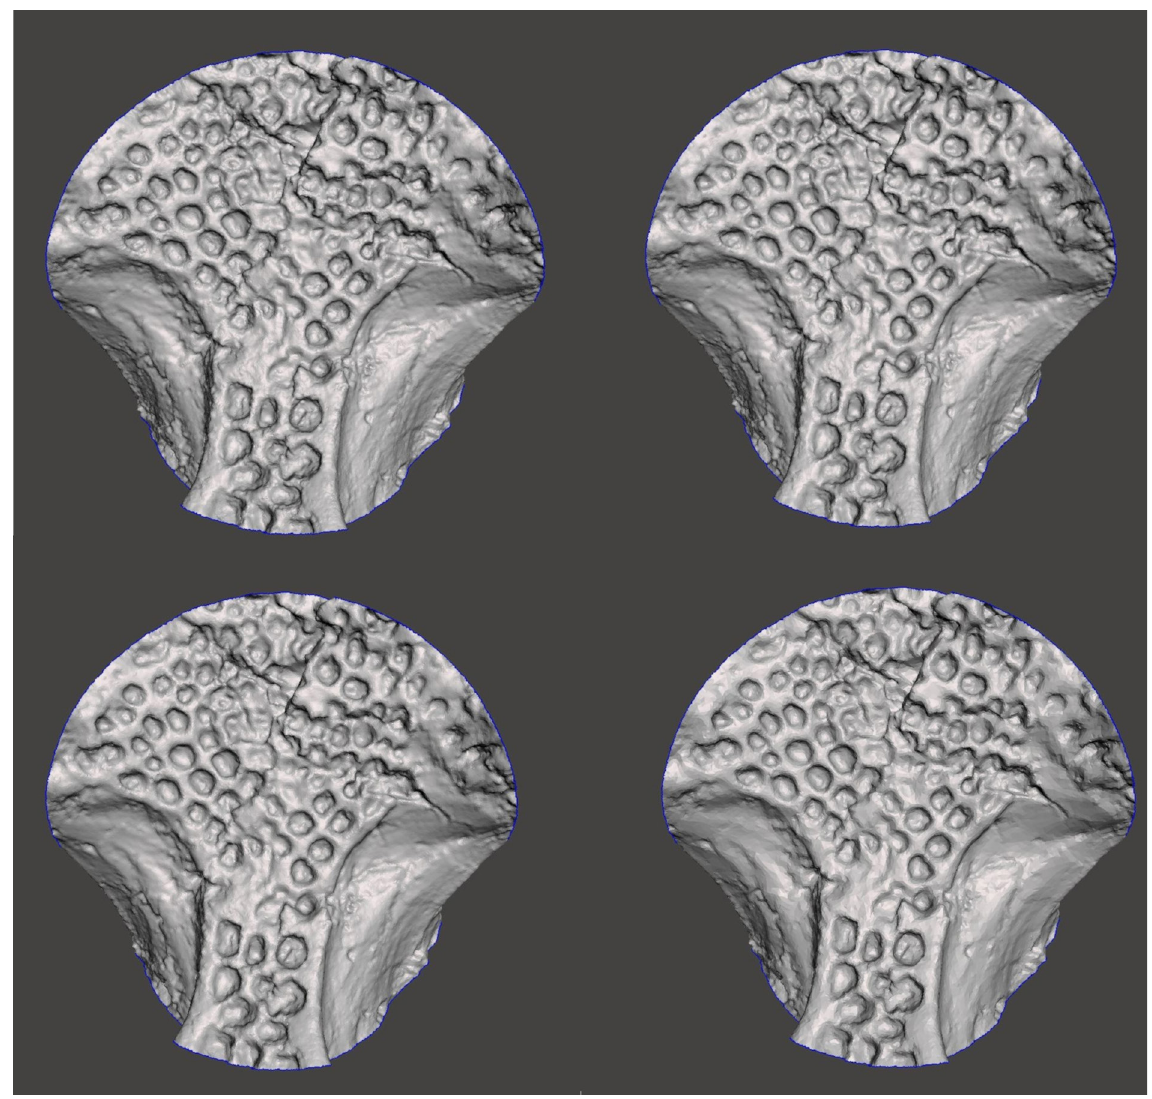
Fig. 5.6. Decimation of a 3D model. The four parts show a 3D model in various degrees of reducing the amount of faces. In the left upper corner is the original and rotating clockwise are the models at 50%, 75% and 90% decimation. Until 75% there is hardly any difference noticeable, while at 90% the cracks become less deep and the faces become more